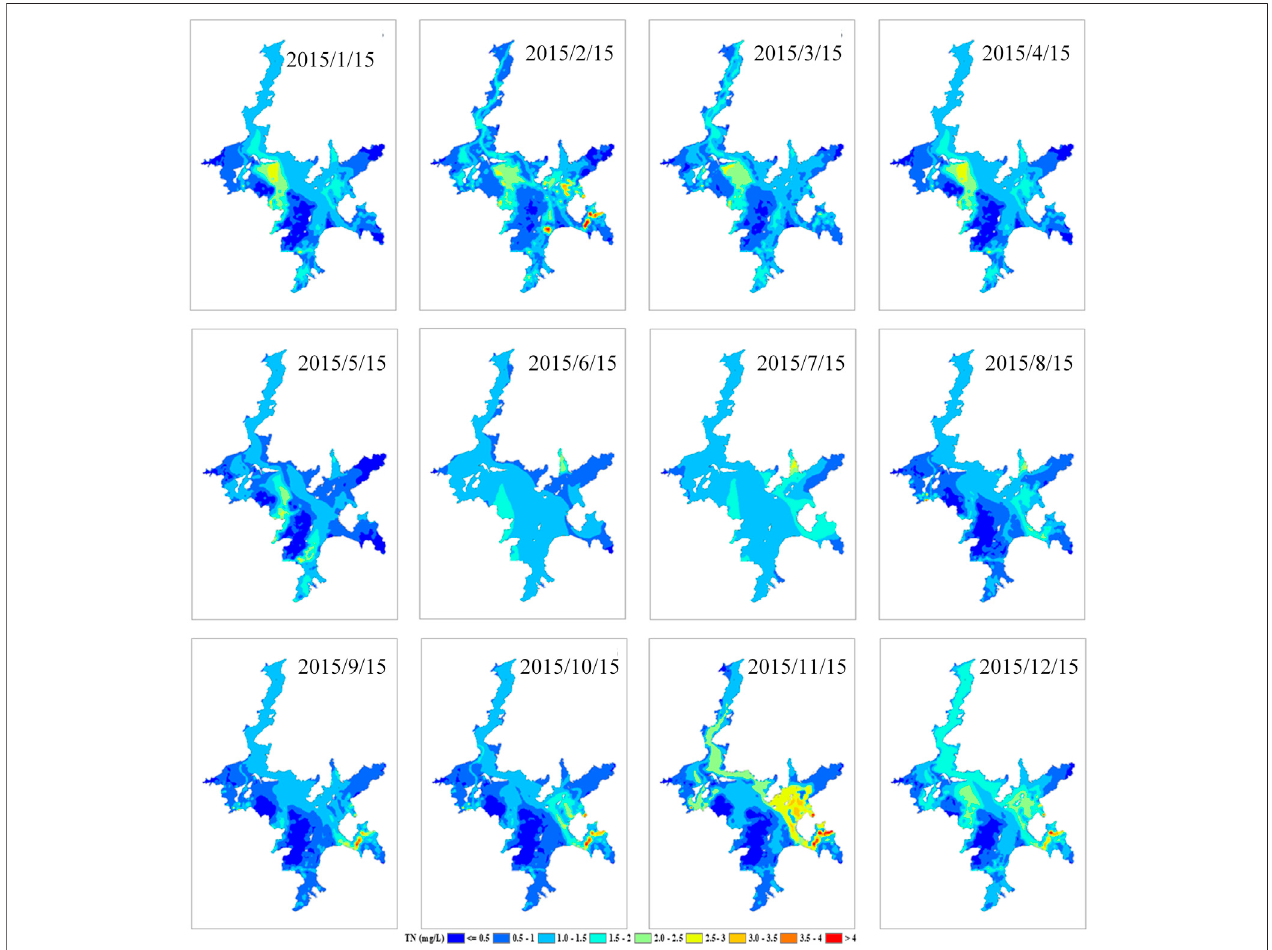
FIGURE 3 | Spatiotemporal distributions of the simulated TN concentrations in Lake Poyang in 2015.